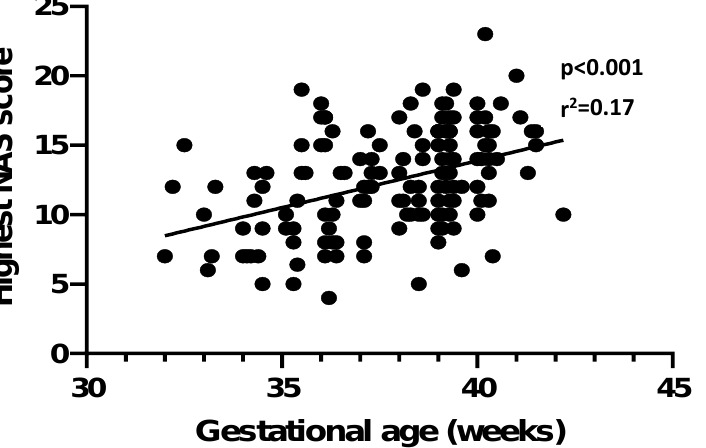
Figure 2. Maximum NAS scores versus gestational age shows a weak correlation with increasing MFS with gestational age.